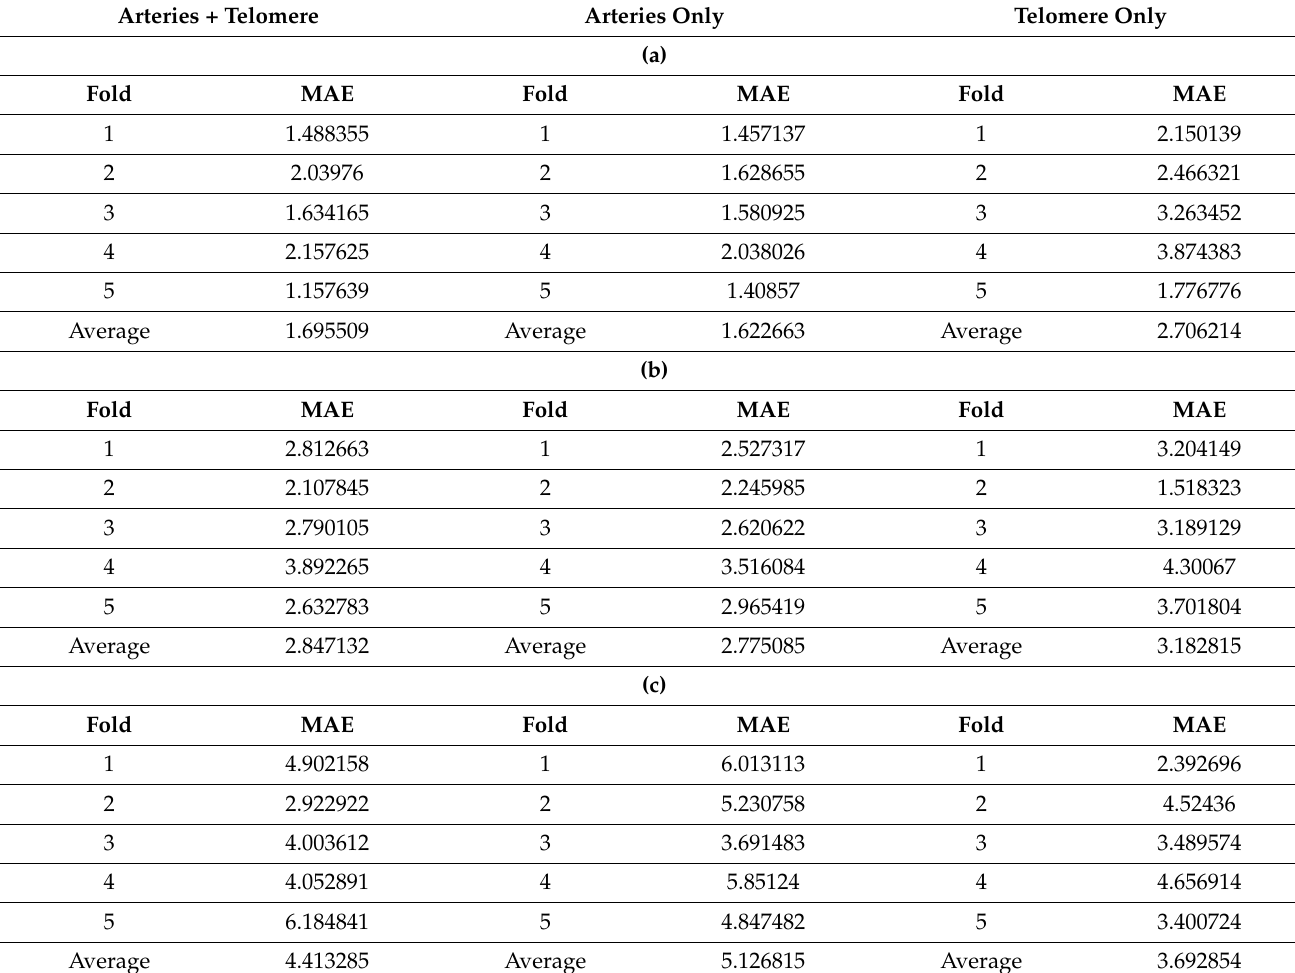
Table 4. ( a ) Mean absolute errors for age predictions (Age group 1). ( b ) Mean absolute errors for age predictions (Age group 2). ( c ) Mean absolute errors for age predictions (Age group 3).